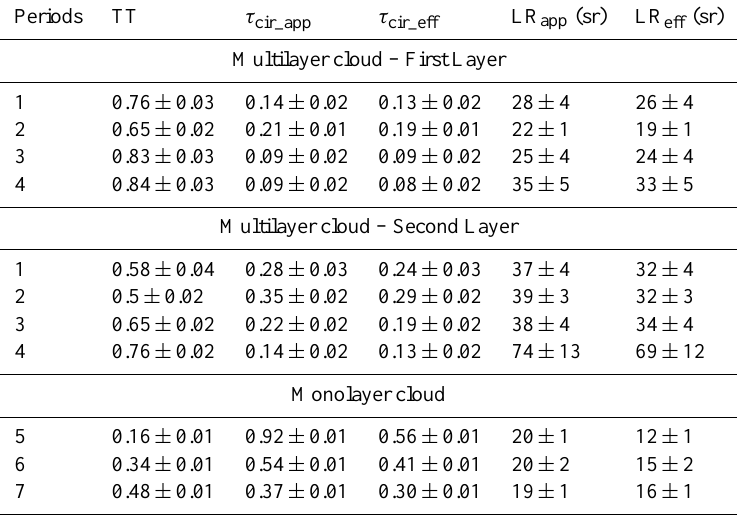
Table 2. Optical properties of cirrus observed over São Paulo City on 11 June 2007. Periods